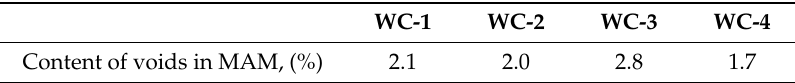
Table 11. Content of voids in MAM for particular series, %.